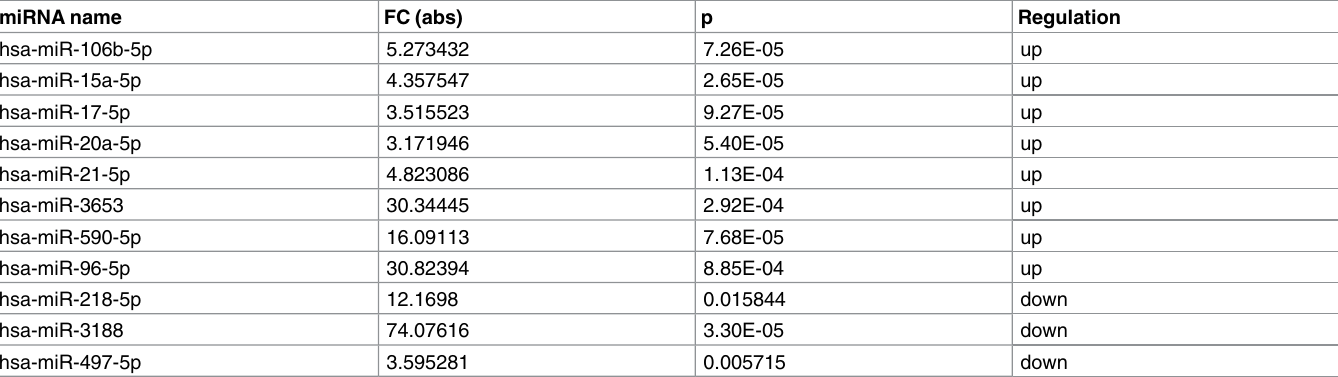
Table 3. Change in miRNA expression by miRNA